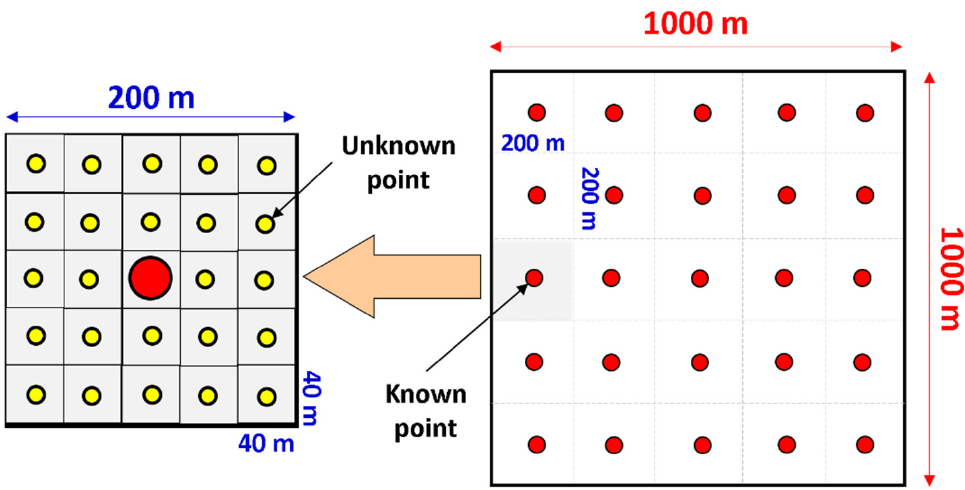
Figure 5. The grid’s dimensions and resolutions for the hypothesized case study.